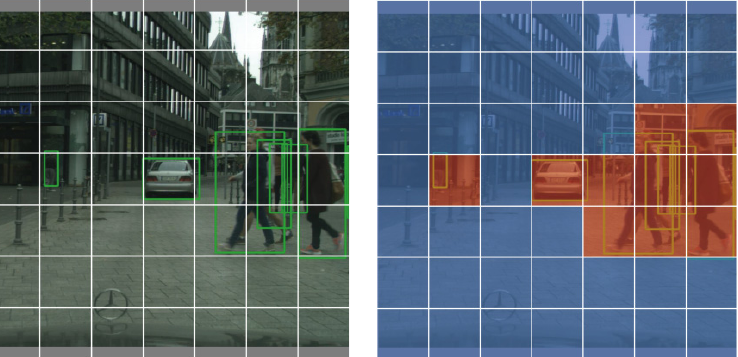
Figure 1. Schematic diagram of spatial domain alignment. Our spatial alignment framework enables more accurate alignment of background and important instances, which can help the backbone network to more accurately activate the main objects of interest in both domains and lead to better adaptive detection